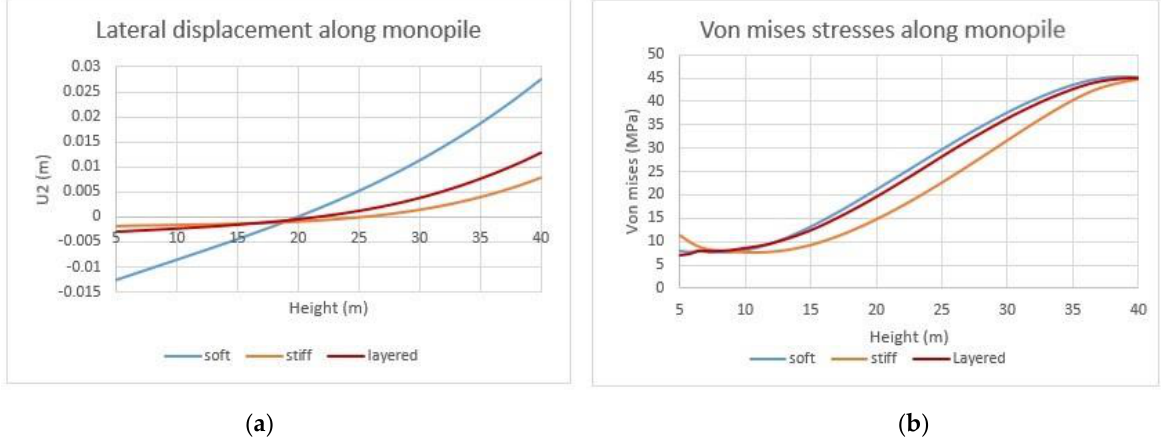
Figure 14. Soil – structure interaction: ( a ) Lateral displacements, ( b ) Von Mises stresses. Figure 14. Soil–structure interaction: ( a ) Lateral displacements, ( b ) Von Mises